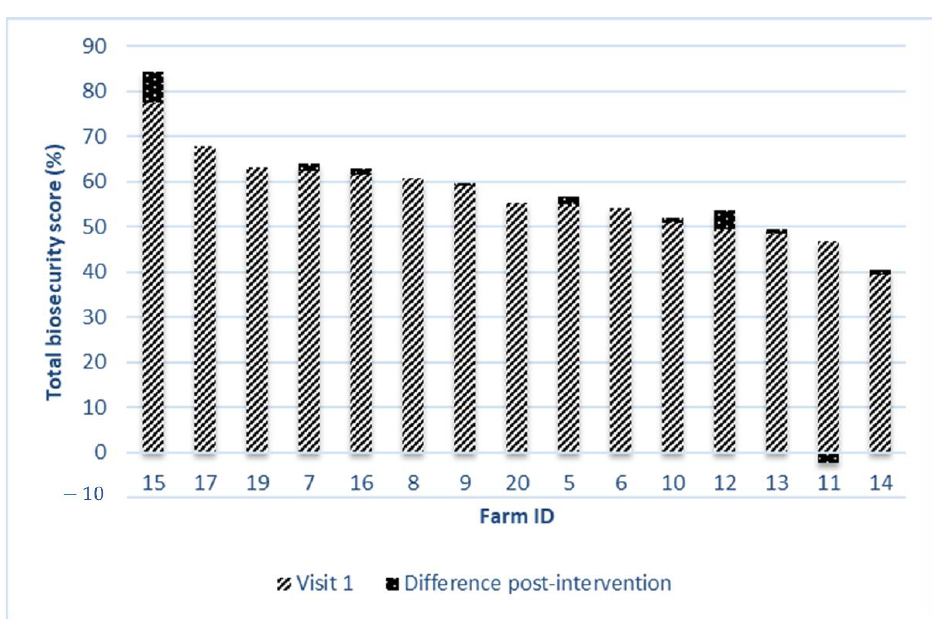
Figure 1. The total biosecurity scores from 15 different fattening farms involved in the study, and their difference post-intervention.